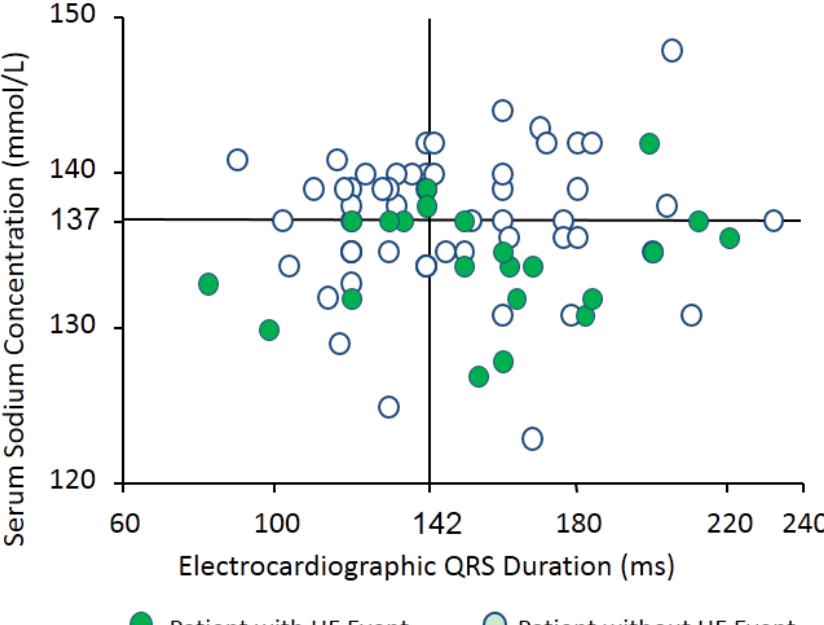
Figure 8. Distribution of serum sodium levels and electrocardiographic QRS duration in patients with congestive heart failure. Cited from